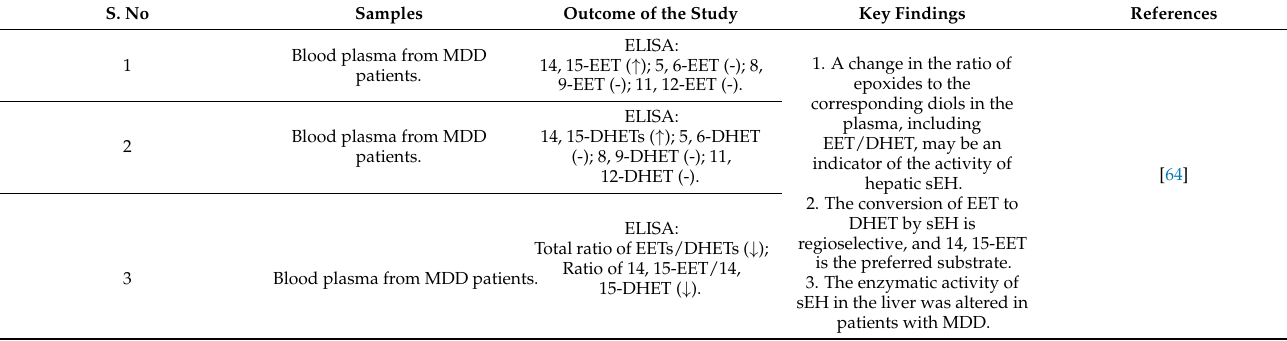
Table 2. Association between hepatic sEH and depression based on the clinical